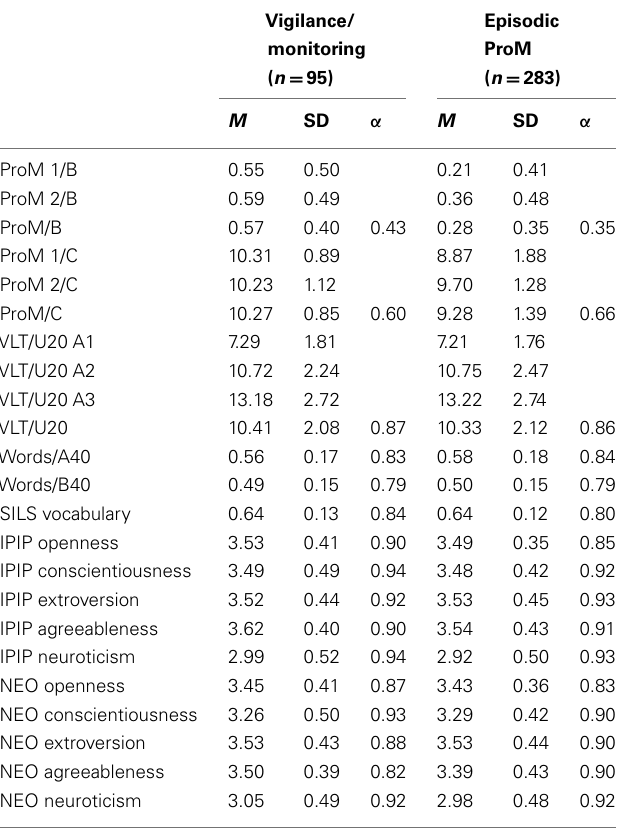
Table 4 | Descriptive statistics and